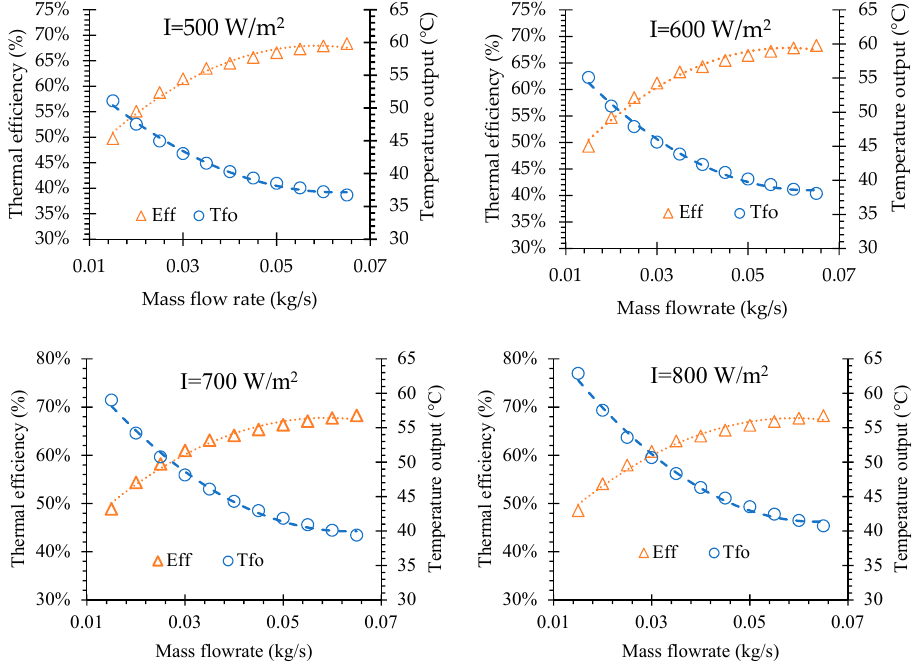
Figure 7. Thermal efficiency against output temperature at different irradiance.